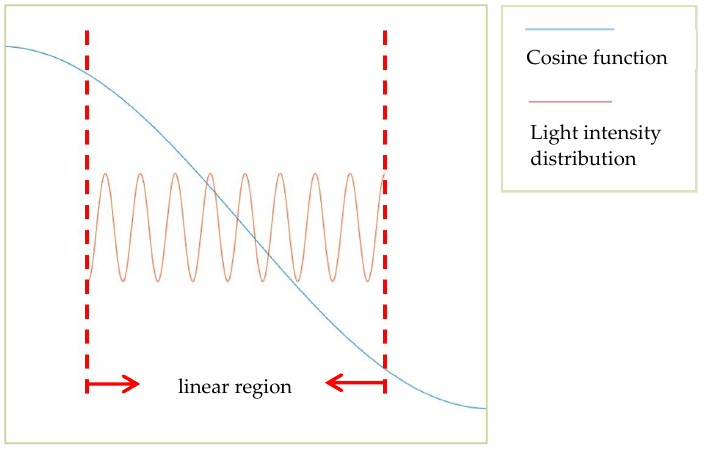
Figure 1. The approximate linear distribution of the cosine function in the vicinity of π /2.